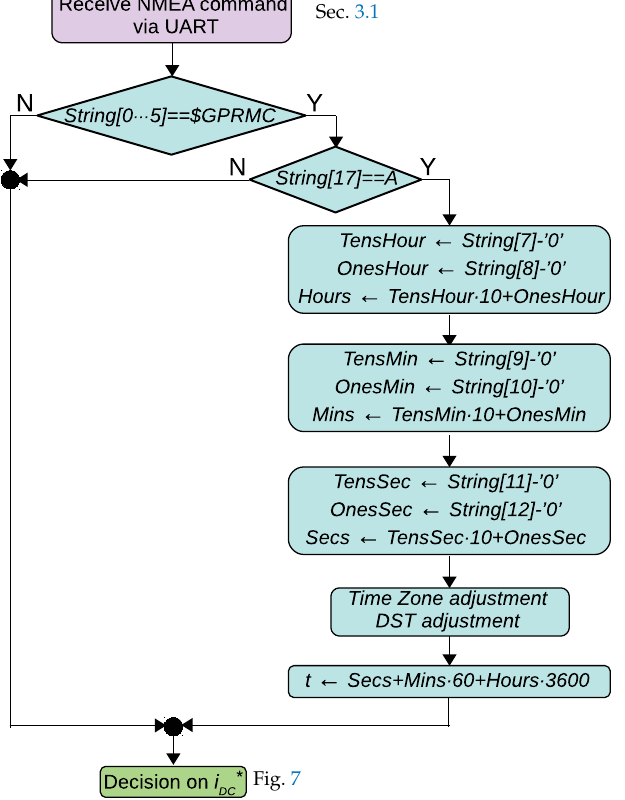
Figure 10. Algorithm for decoding of NMEA command and extraction of time of the